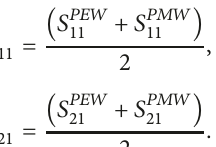
Figure 10: Magnitude (dB) of S 11 and S 21 for model A2 with TEM and TM 0 the virtual circular waveguide containing the sample (thickness d